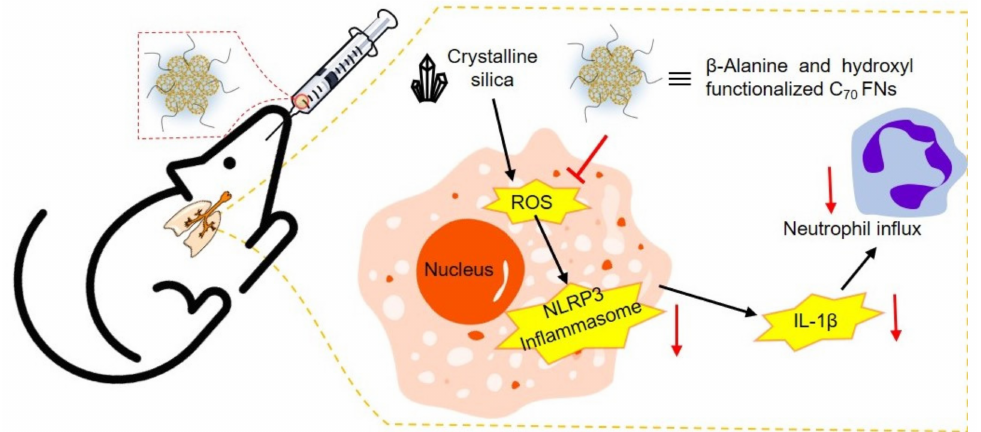
Figure 18. Proposed mechanism of fullerene nanoparticles (FNs) for the treatment of silicosis- associated pulmonary inflammation, crystalline silica significantly activates the intracellular ROS dependent pathway, which can be effectively attenuated by FNs. ROS: reactive oxygen species; NLRP3: NACHT, LRR, and PYD domains-containing protein